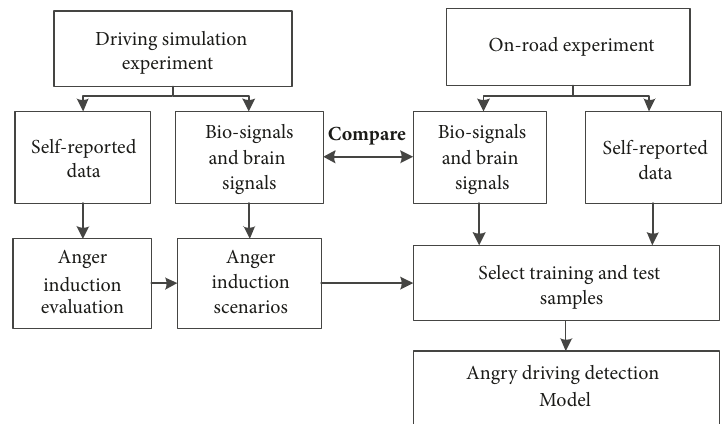
Figure 1: The technical route.